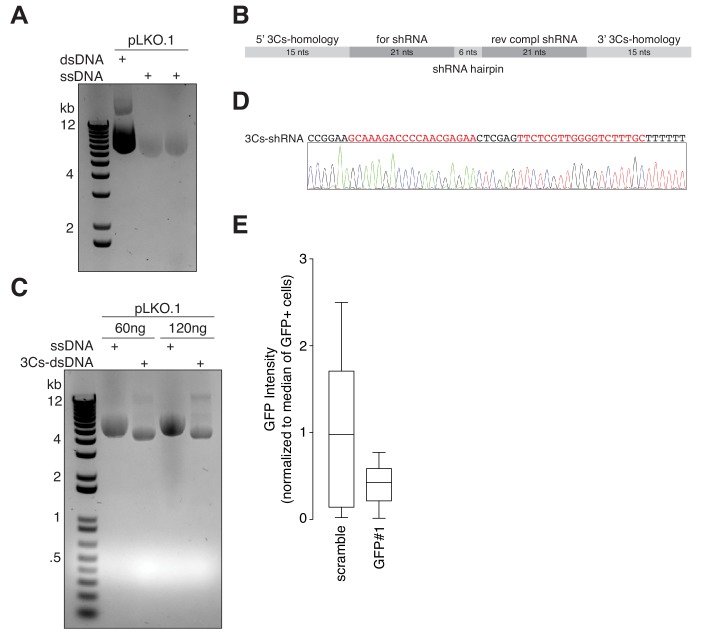
3Cs facilitates the generation of shRNA libraries.(A) Gel electrophoresis of ssDNA from the conventional shRNA-expressing lentiviral plasmid pLKO.1. (B) 3Cs-shRNA oligonucleotide design. Regions with homology to pLKO.1 are shown in light grey, whereas complementary shRNA sequences are displayed in dark grey. 3Cs-shRNAs have a length of 78 nucleotides. (C) Two different amounts of pLKO.1 circular ssDNAs (60 ng and 120 ng) were annealed with a single 3Cs-shRNA oligonucleotide, encoding a GFP-targeting shRNA, to produce 3Cs-dsDNA, which was analyzed by gel electrophoresis. (D) 3Cs-dsDNA derived as for panel (C) was amplified in E. coli. SANGER-sequencing of the amplified plasmid DNA confirmed the successful integration of the GFP-targeting shRNA sequences (highlighted in red). (E) GFP-expressing hTERT–RPE1 cells were transduced with either a scrambled or a GFP-targeting shRNA and analyzed by flow-cytometry in biological replicates (n = 2). Please note, the GFP intensity was reduced by more than 60%, indicating functionality of 3Cs-shRNA reagents.